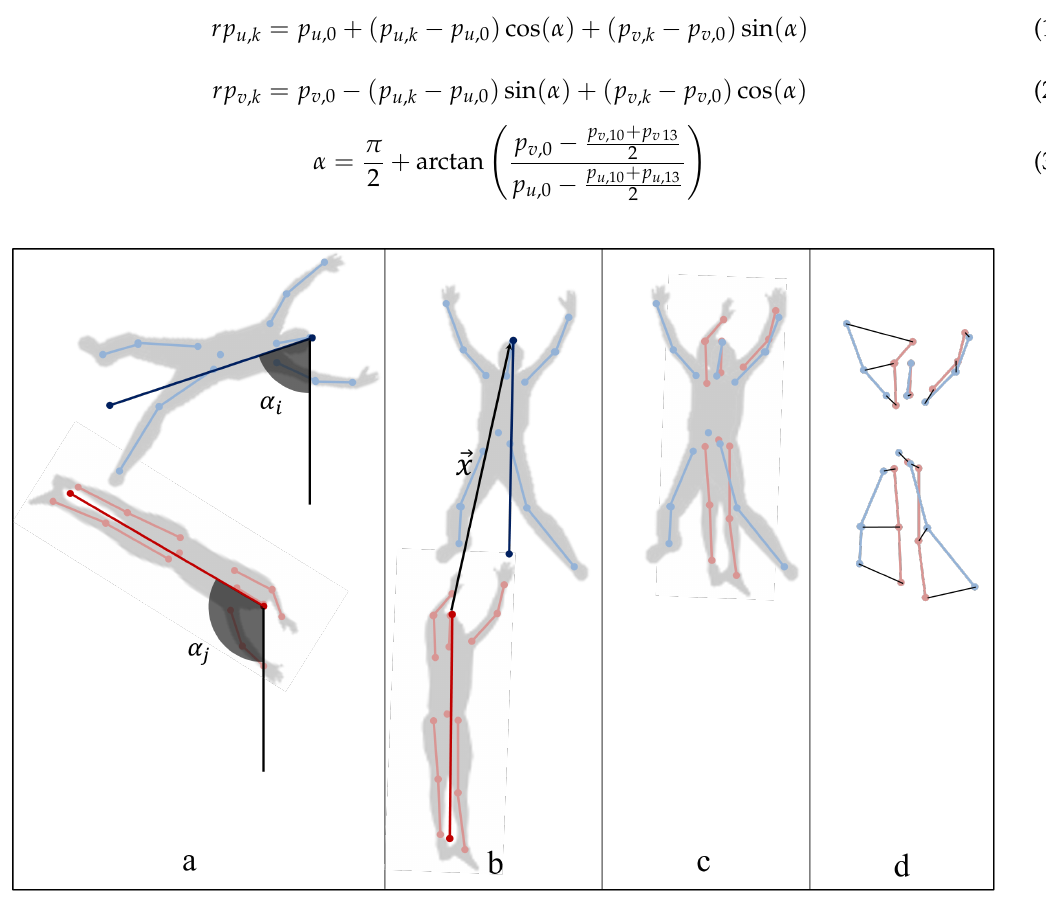
Figure 4. Pose dissimilarity measure d p ( t i , h j ) : ( a ) track, P t i , and human object, P h j , poses; ( b ) track, RP t i , and human object, RP h j , rotated poses; ( c ) track rotated pose, RP t i , and human object rotated and translated pose, RTP h j ; ( d ) joints